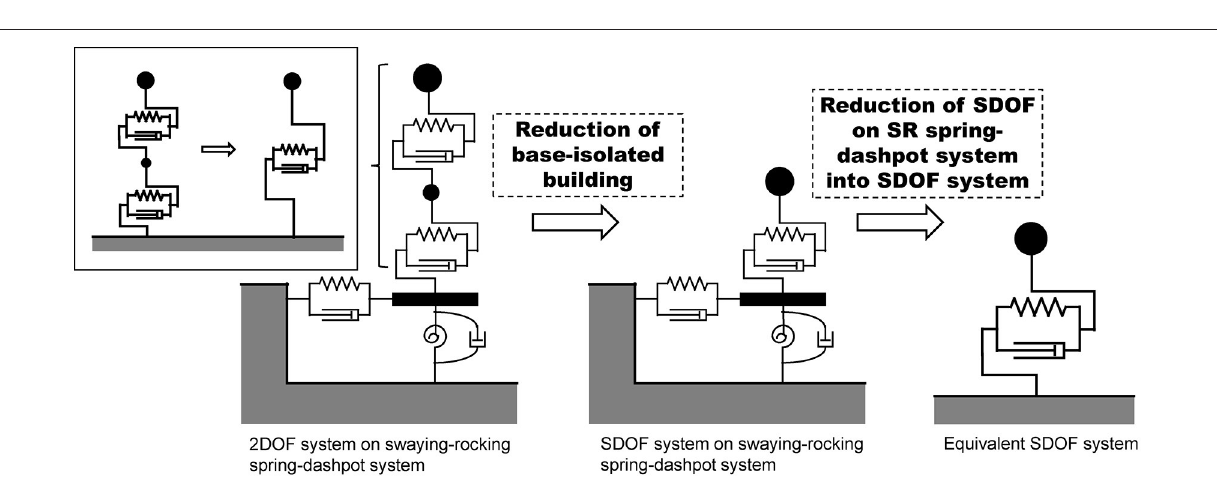
FIGURE 3 | Base-isolated building considering soil-structure interaction and its modeling into 2DOF model on swaying-rocking spring-dashpot system.